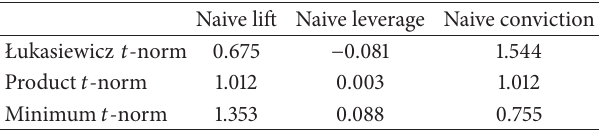
Table 1: Comparison of lift, leverage, and conviction computed with different 𝑡 -norms on stochastically independent data generated randomly from uniform